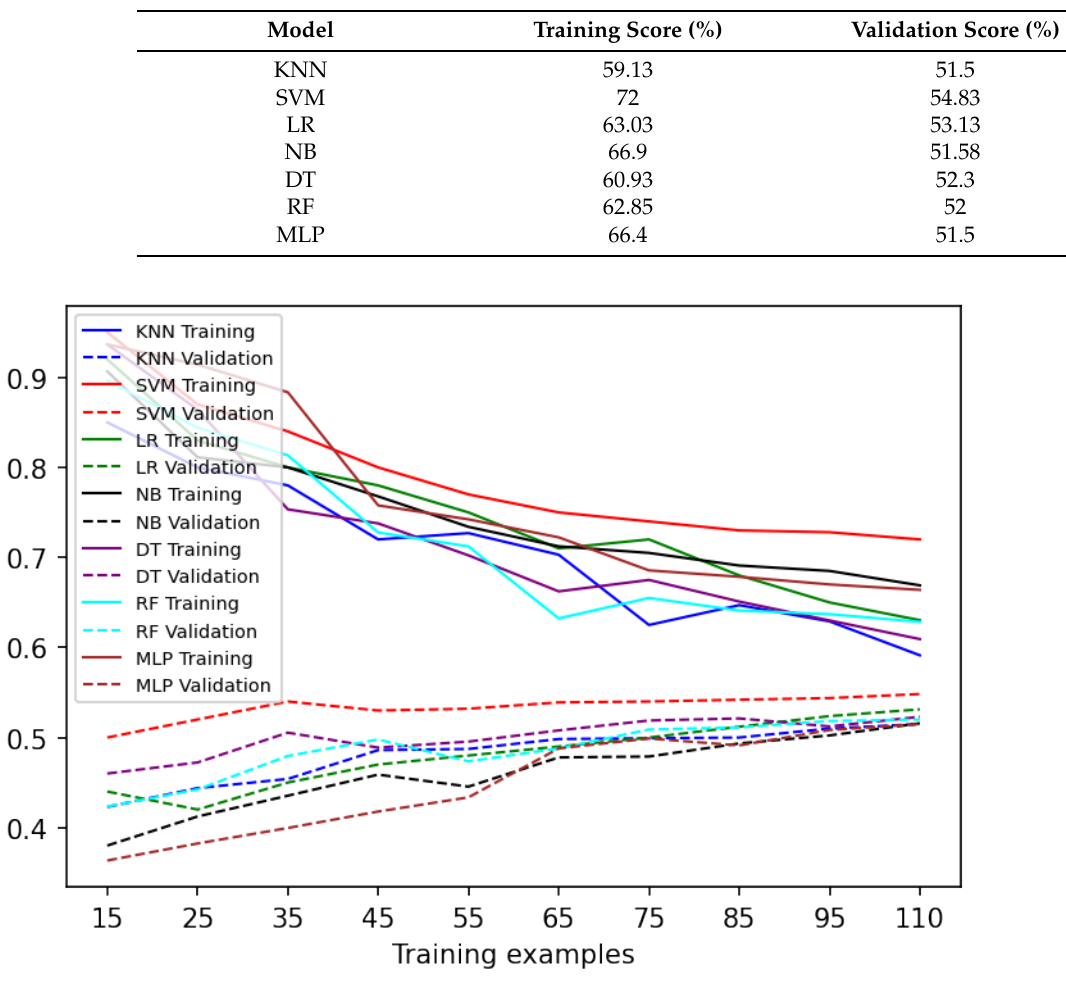
Table 10. Average training and validation score for all models.